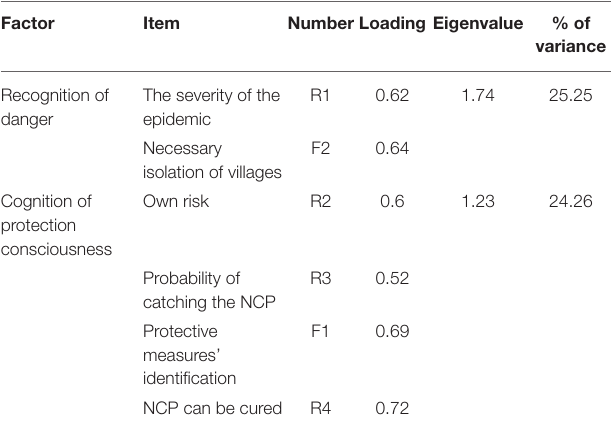
TABLE 1 | Items loadings, eigenvalues and variance of the RCS with